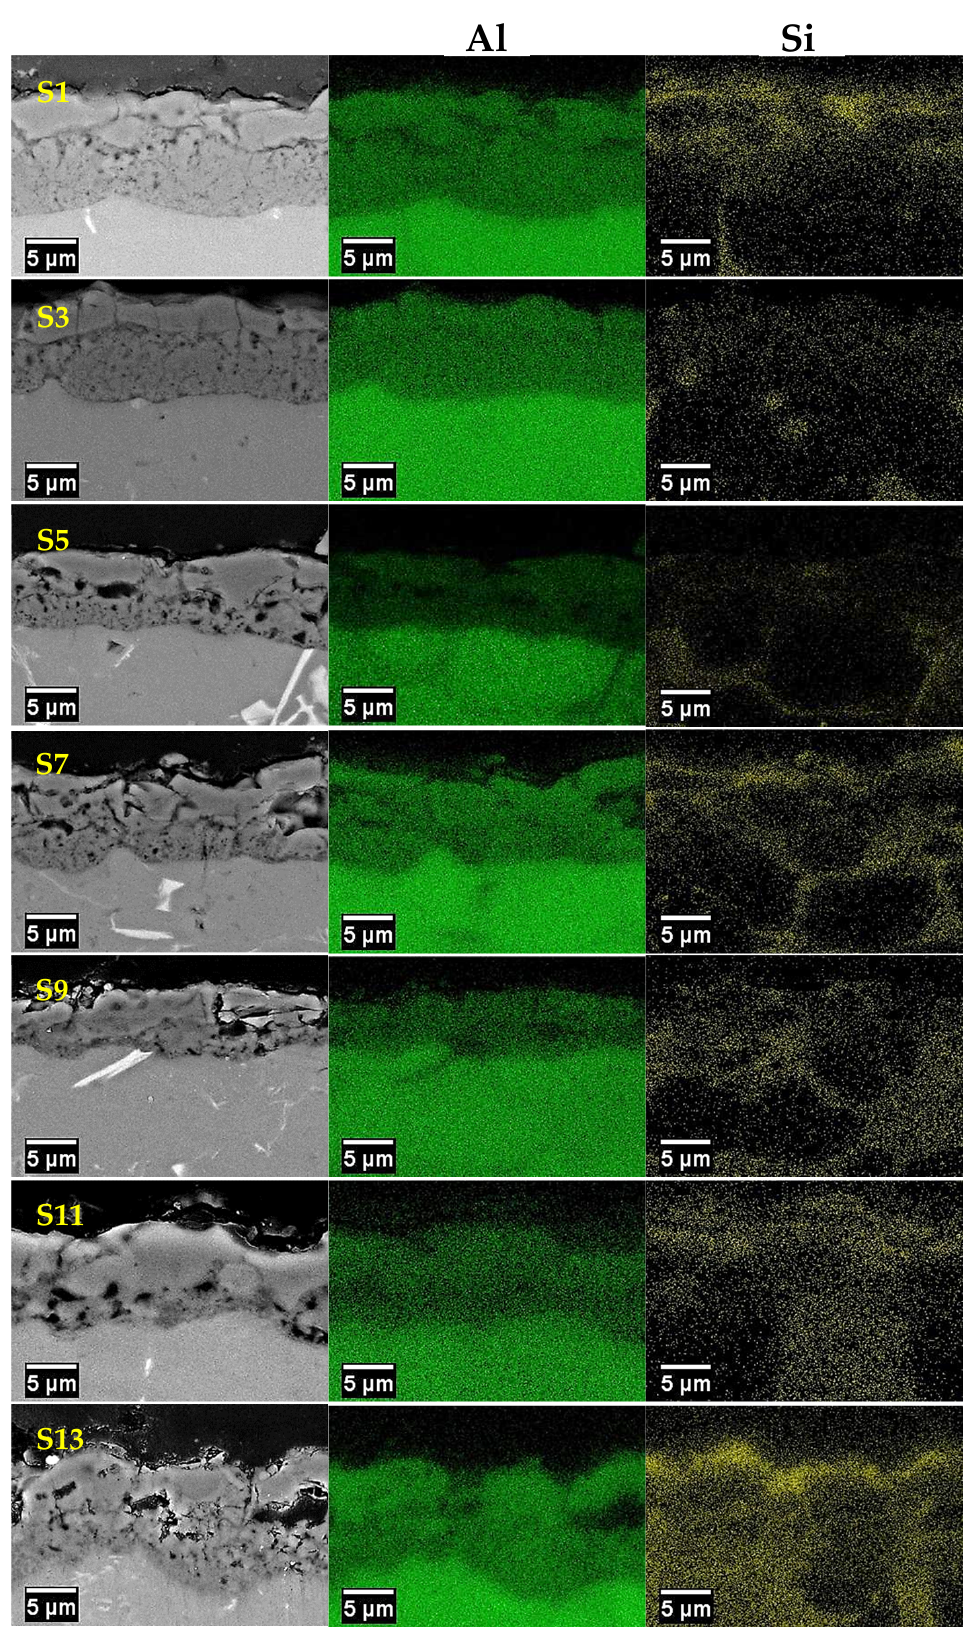
Figure 9. The elemental map on the cross-section of the PEO specimens prepared by the silicate-based electrolyte consists of Al and Si elements marked by green and yellow colors, respectively.